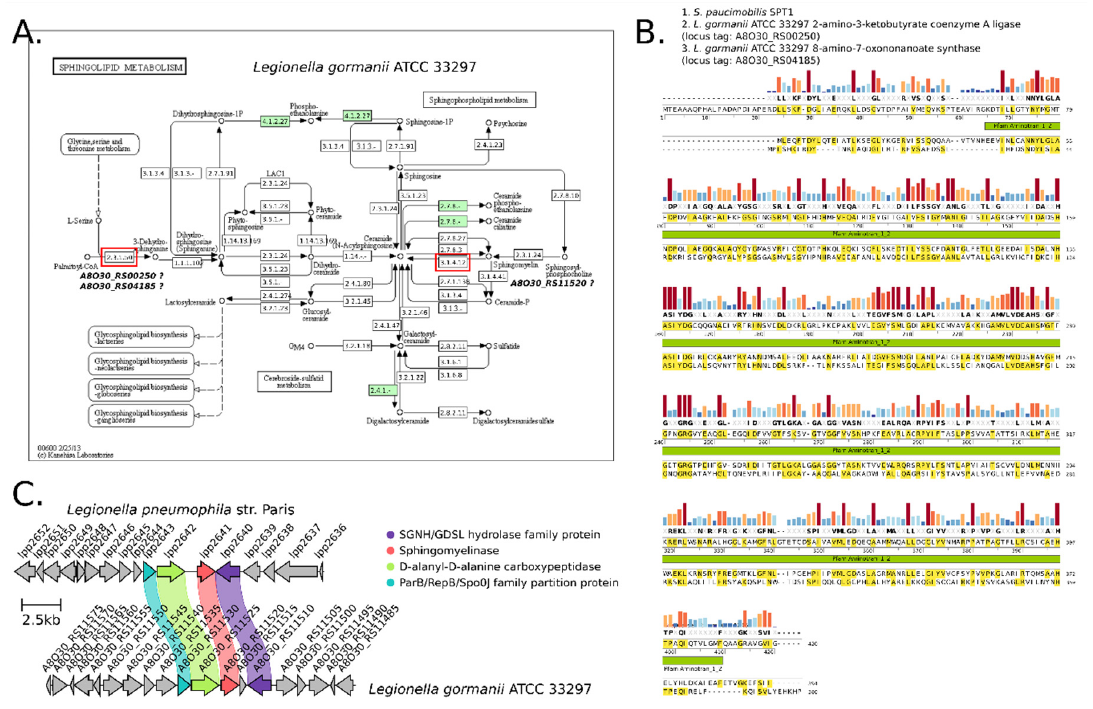
Figure 7. Searching for pathways of sphingolipid metabolism in the genome of L. gormanii ATCC 33297. ( A ) Mapping the L. gormanii ATCC 33297 genome annotation to the KEGG sphingolipid metabolism pathway map (map00600). Chemical compounds are represented as circles, and gene products are represented as rectangles. The two important entry enzymes in the pathway: serine palmitoyltransferase (SPT, EC 2.3.1.50, K00654) and sphingomyelin phosphodiesterase (SMPD1, 3.1.4.12, K12350) are outlined in red. Green rectangles represent enzymes found in the genome of L. gormanii ATCC 33297 via KofamKOALA and with assigned KO identifiers. For the first step of sphingolipid synthesis, i.e., condensation between serine and the acyl-CoA thioester, no SPT enzyme was found in the L. gormanii ATCC 33297 genome, based on the standard thresholds for KO identification. However, there are sequences encoding SPT protein homologues (8-amino-7-oxononanoate synthase, locus tag: A8O30_RS00250; 2-amino-3-oxobutyrate coenzyme A ligase, locus tag: A8O30_RS04185) present, belonging to the bacterial α -oxoamine synthases family. In the case of SMPD1, which catalyzes the breakdown of sphingomyelin into ceramide and phosphatidylcholine, although KO identification failed to assign this function, the homologue of predicted sphingomyelinase encoded by the lpp2641 L. pneumophila str. Paris gene with a level of identity of 61% was found in the L. gormanii ATCC 33297 genome. ( B ) Multiple protein sequence alignment of reference bacterial SPT from Sphingomonas paucimobilis (Q93UV0_SPHPI) and SPT homologues present in the genome of L. gormanii ATCC 33297. The color-coded bar at the top indicates the conservation degree. Below, there is the consensus sequence. In addition, the recognized Pfam domain (Pfam_Aminotran_1_2) is marked with a green rectangle, which indicates the presence of certain mechanistic features, such as the covalent binding of the pyridoxal-phosphate group to a lysine residue. The level of identity between Sphingomonas paucimobilis SPT and L. gormanii ATCC 33297 homologues is at the level of 30%. The alignment was generated using the Multiple Sequence Comparison by Log-Expectation (MUSCLE) algorithm in SnapGene (GSL Biotech). ( C ) Comparison of genomic regions encoding SMPD1 between in L. pneumophila str. Paris and L. gormanii ATCC33297. The individual coding sequences are marked with arrows according to their orientation. Above is the locus tag for the individual coding sequence in the GenBank database. The color lines joining the two regions indicate the level of identity above the designated threshold (0.22) for specific proteins. There are four CDSs with significant similarity within the analyzed regions coding for SGNH/GDSL hydrolase (violet), sphingomyelinase (red), D-alanyl-D-alanine carboxypeptidase (green), and ParB partition protein (green). This may indicate a common evolutionary origin of SMPD1 in these species. The comparison and visualization were made using the clinker